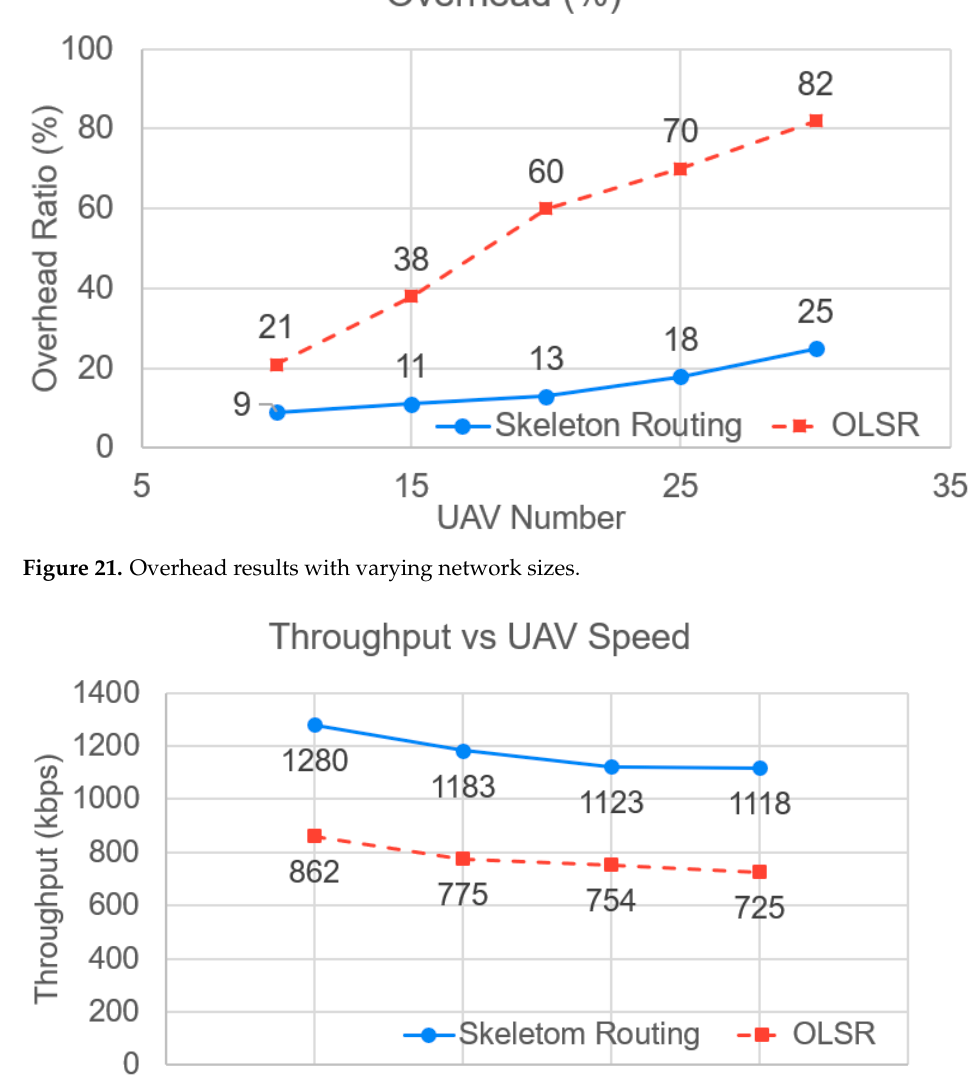
Figure 20. Packets reception rate results with varying network sizes.